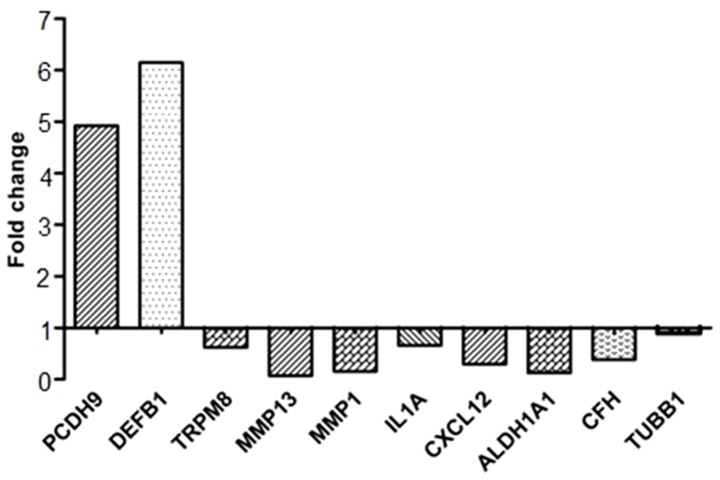
Quantitative PCR validation of microarray results.The figure shows bar graphs presentation of the differential expression of the selected genes in the shRNA-RUNX2 clone 3 (cl-sh3) compared to the control clone. The relative copy number was calculated based on the target gene/18S ribosomal RNA ratio. Values more than or equal to 1 represent gene upregulation and more than 1 display gene downregulation. The analysis confirmed a higher level of PCDH9, DEFB1 expression and lower levels of TRPM8, MMP13, MMP1, IL1A, CXCL12, ALDH1A1, CFH, TUBB1 expressions in the cl-sh3 clone.